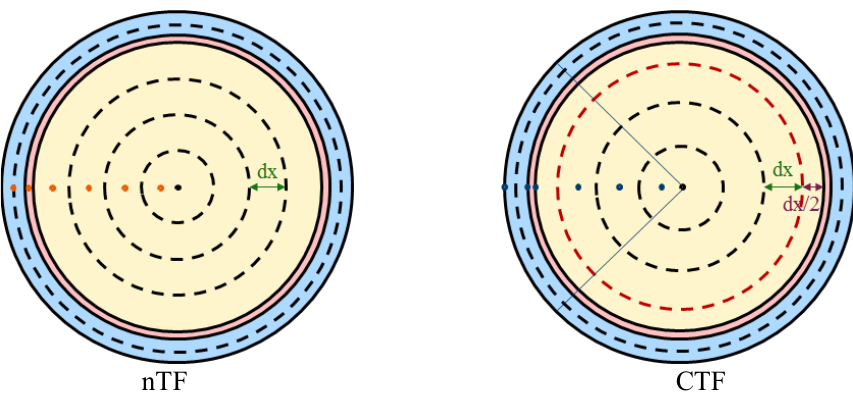
Figure 3. Radial discretization of the fuel pin in nTF and CTF and for the fuel conduction